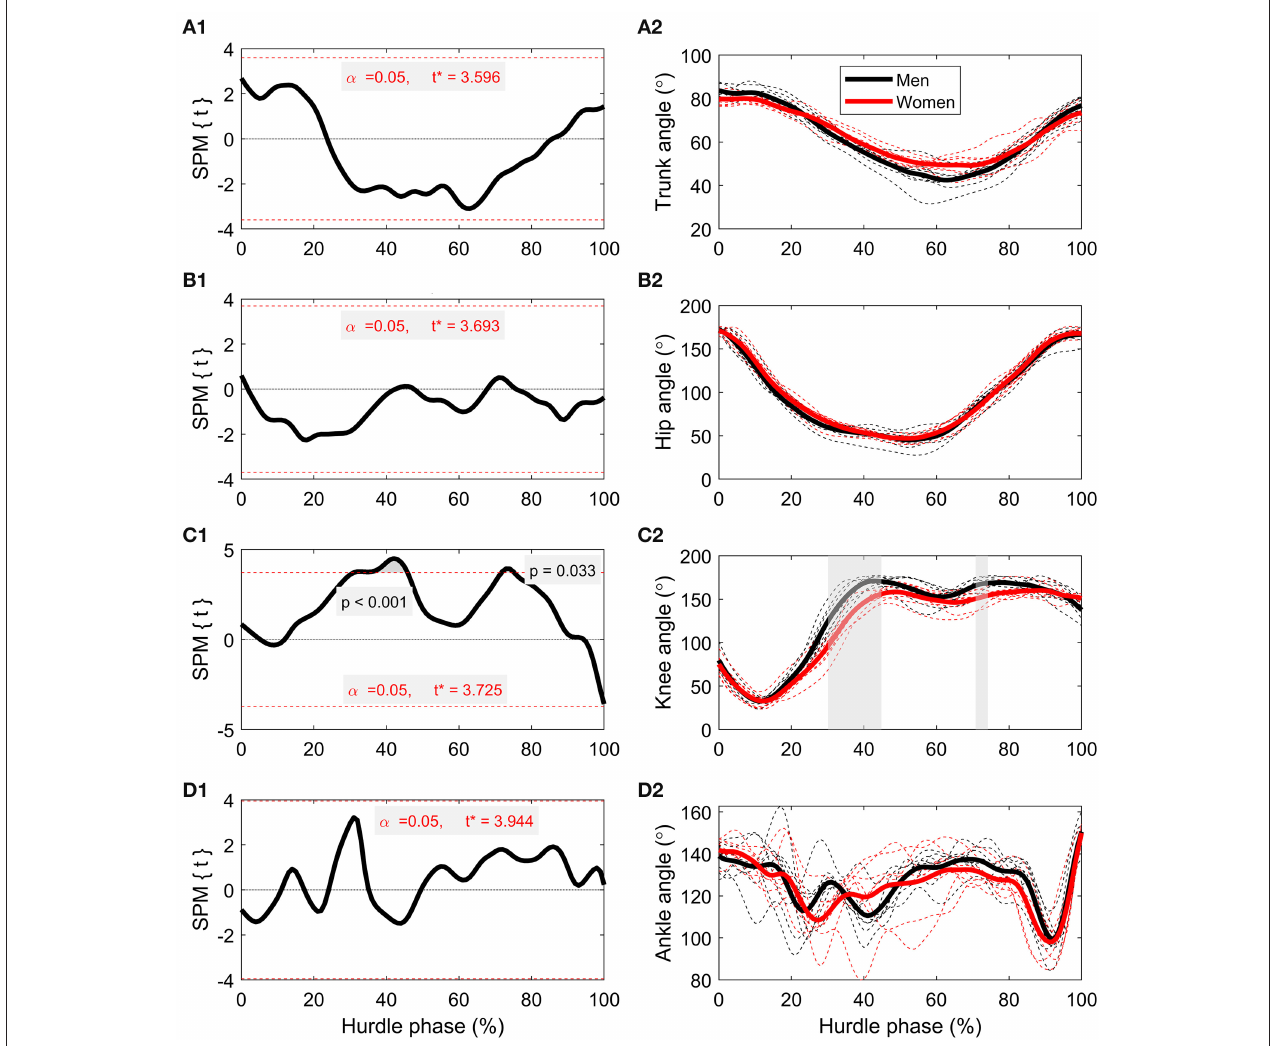
FIGURE 3 | (A1,A2) Time-series comparisons between men and women for trunk angle, (B1,B2) hip angle, (C1,C2) knee angle, and (D1,D2) ankle angle. The left-hand column contains the SPM t -statistics curves, and the right-hand column contains grouped mean curves (thicker, solid lines) as well as individual athlete data (thinner, dashed lines) for men (black lines) and women (red lines). Gray-shaded regions correspond with suprathreshold clusters detected through